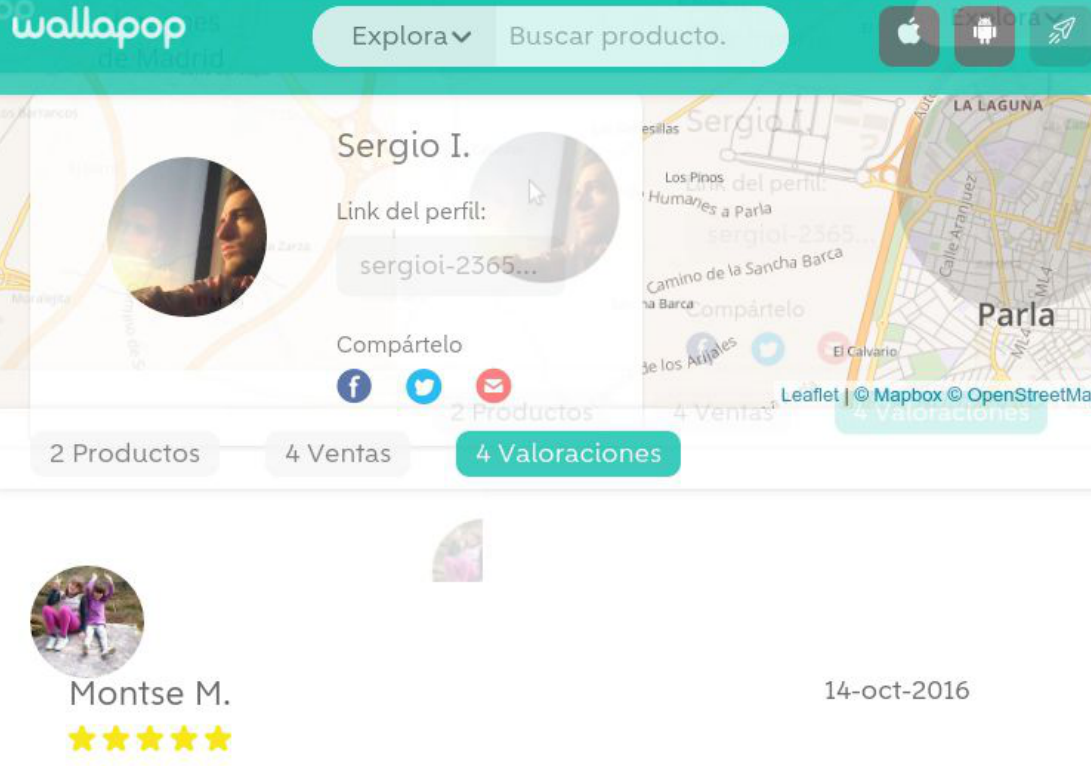
Figure 1. Wallapop user